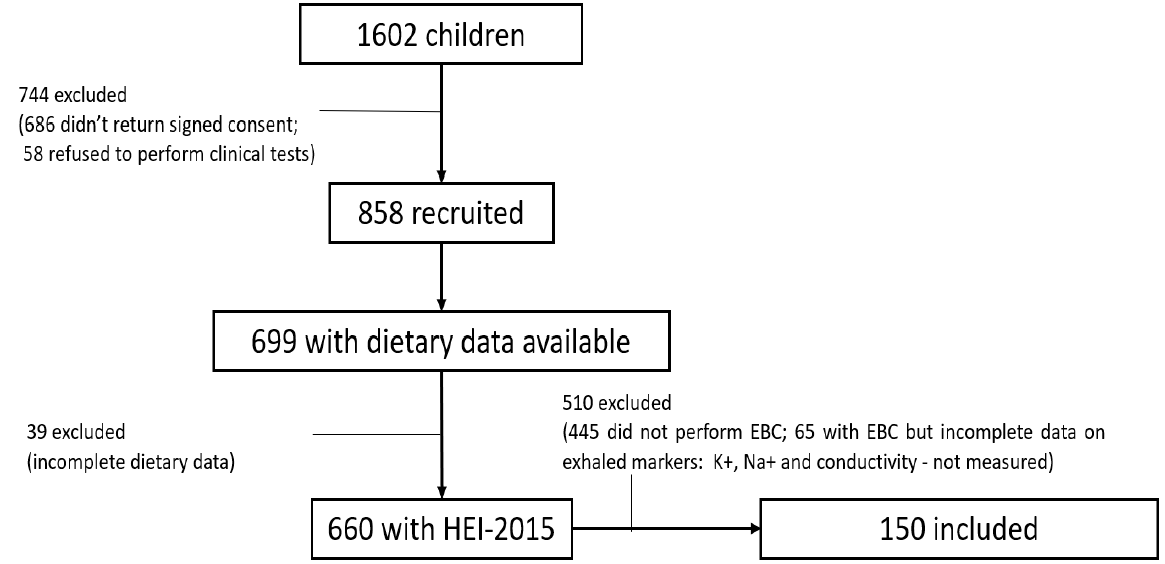
Figure 1. Flow chart of the included participants.